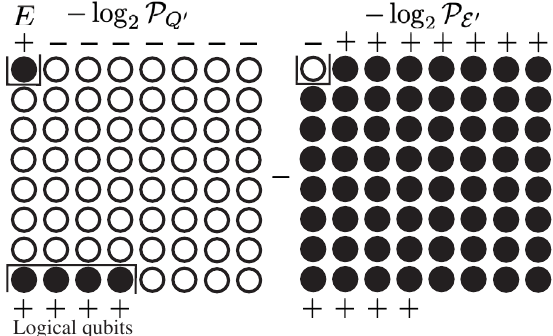
FIG. 10. Approximate description of below-threshold behavior in the Ising model. The coherent quantum information is the free energy cost of flipping the top boundary condition on e and ¯ e in the ordered phase of the Ising model. Below threshold, the top boundary condition on ¯ e polarizes the system into the ordered phase aligned along the same direction. The error-correction threshold occurs when the bulk of the system on the left flips to be polarized in the þ direction as the size of e is increased, which is a first-order domain-wall pinning